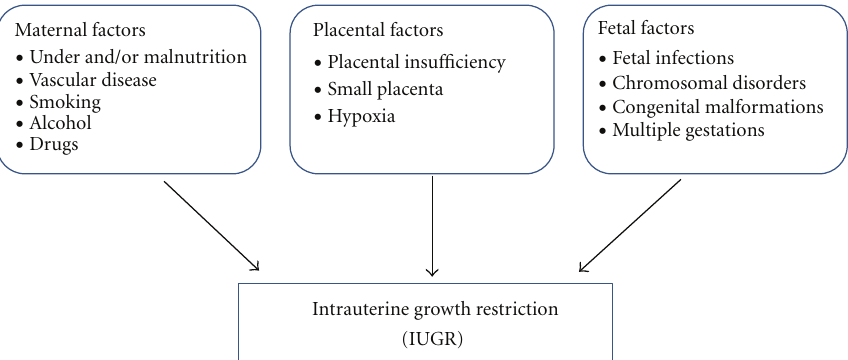
Figure 1: Intrauterine growth restriction (IUGR) can result from a variety of maternal, placental, and fetal factors, either individually or in